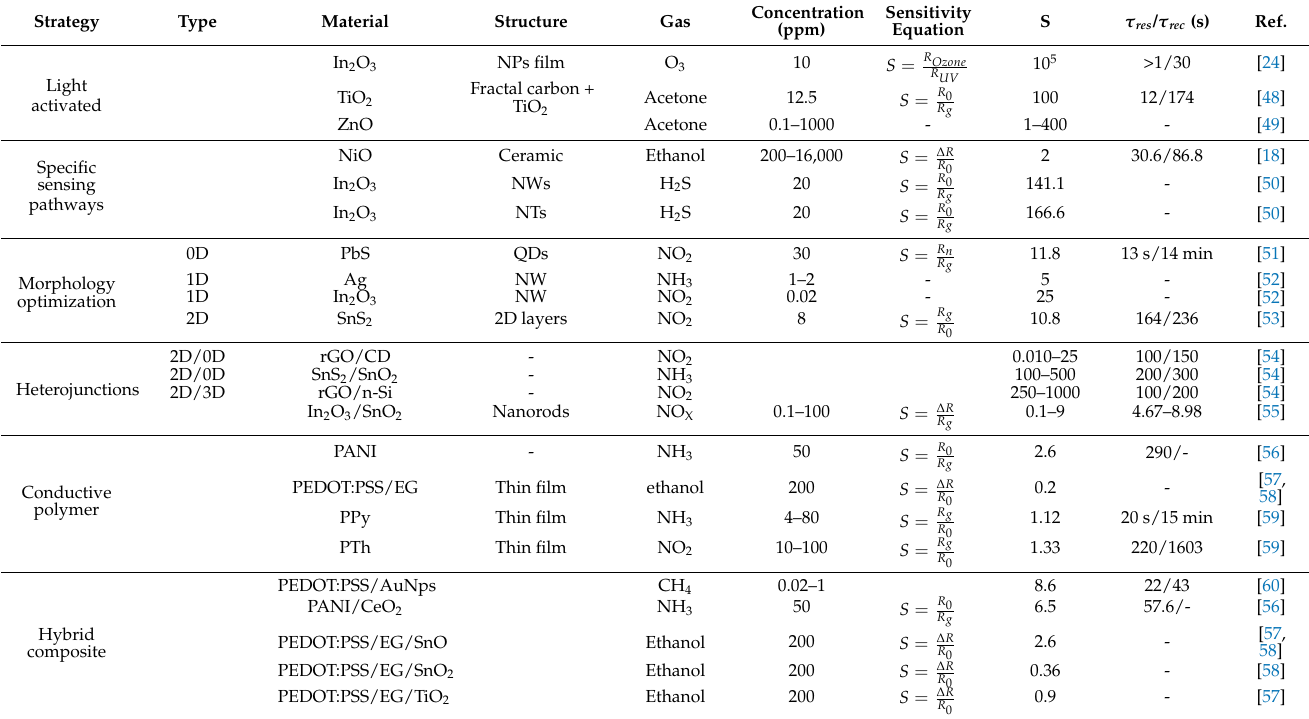
Table 1. Summary of different reported strategies to achieve room temperature response for conduc- tometric gas